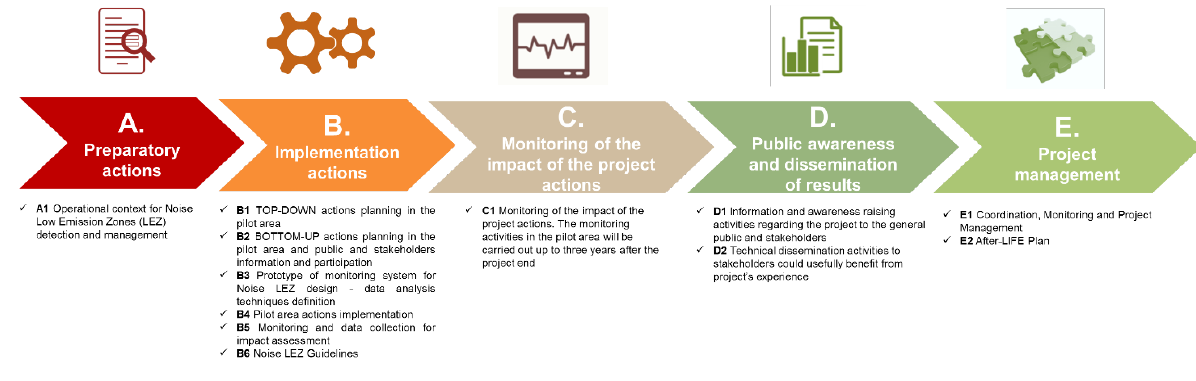
Figure 2: LIFE MONZA Project